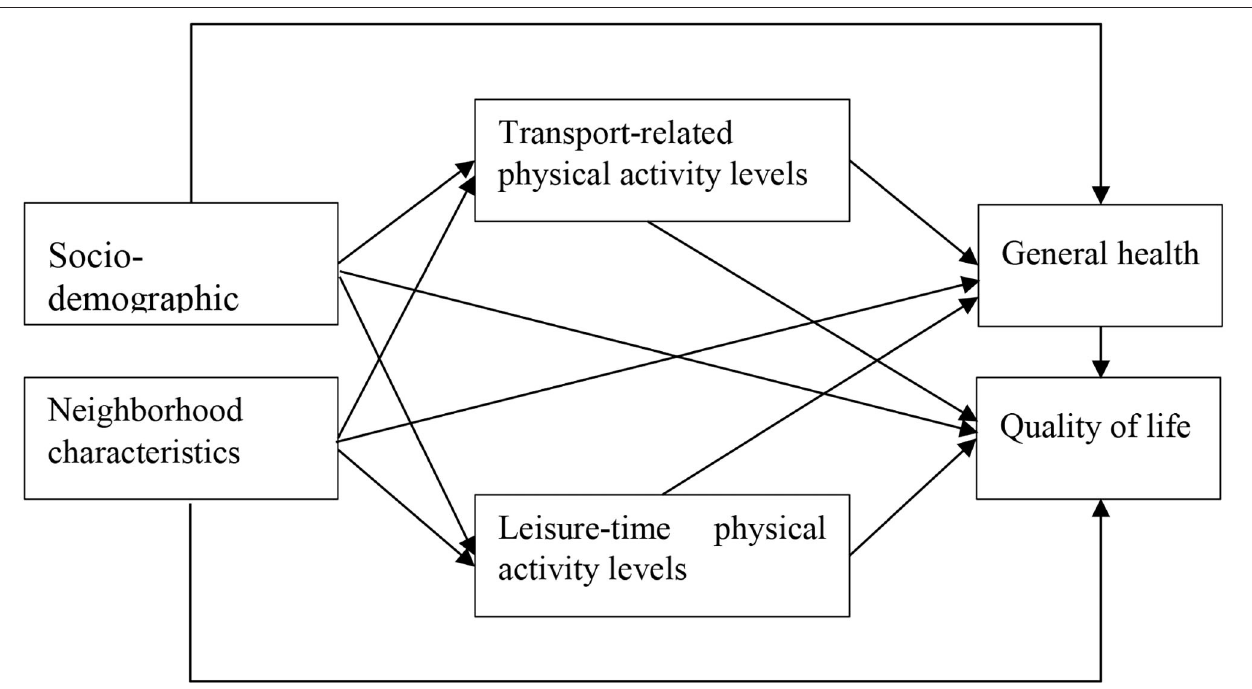
FIGURE 1 | Conceptual